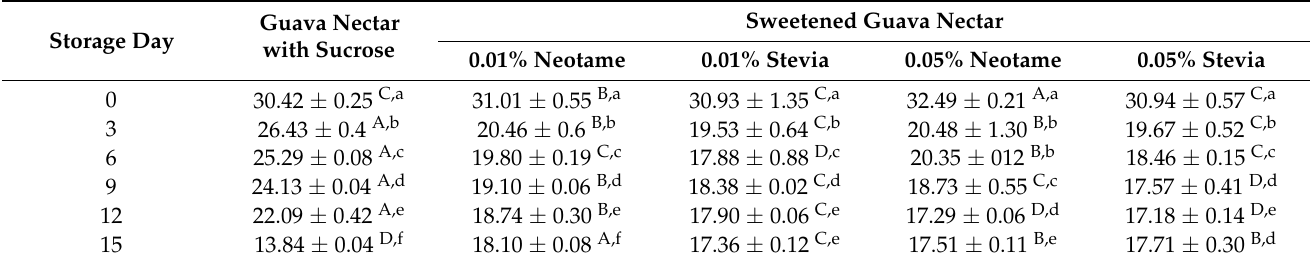
Table 1. Effect of different sweetener on turbidity of guava nectar during 15th of storage day at 5 ◦